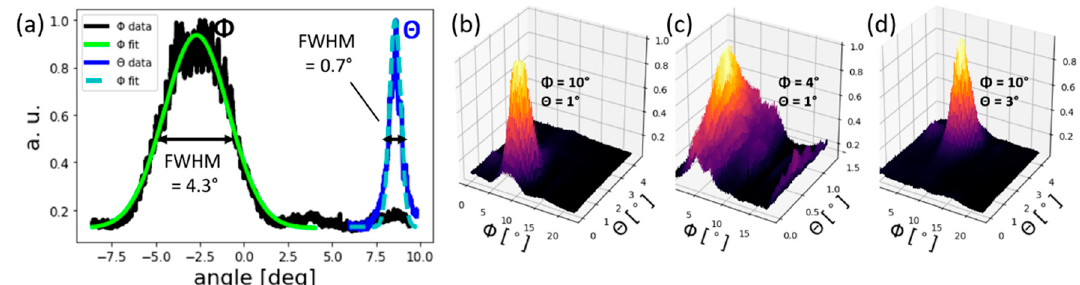
Figure 7. ( a ) Cross-sections in ϕ and θ of the main lobe to determine the FWHM. ( b – d ) Examples of output beam intensity profiles showing beam steering in two dimensions.